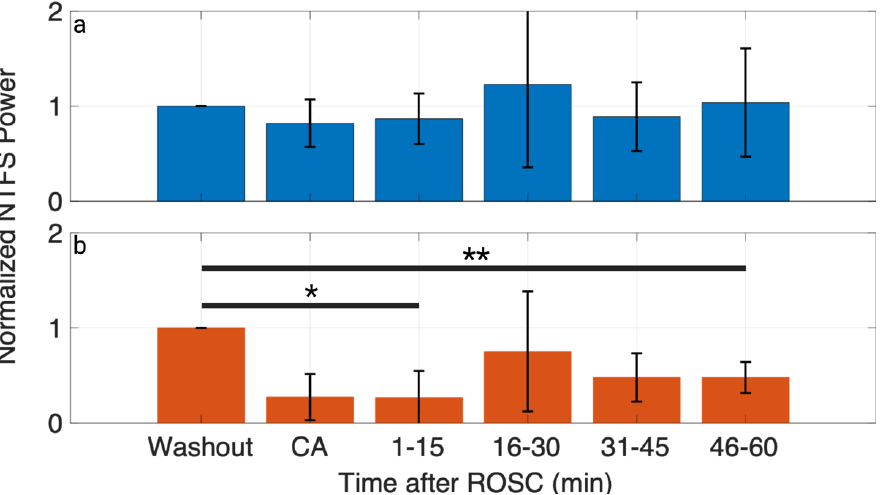
Figure 6. HFO NTFS power showed a significant decrease after 7 min of CA. ( a ) NTFS power evo- lution for group CA3 ( n = 5). ( b ) NTFS power evolution for group CA7 ( n = 6). * p < 0.05, ** p < 0.01. Created with